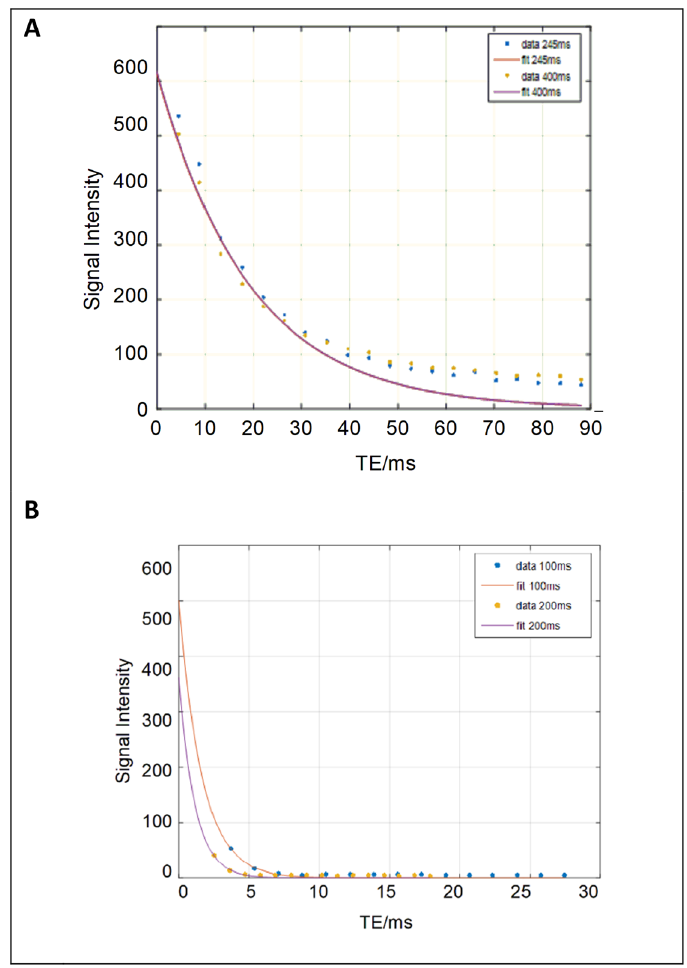
Figure 3. Decay curve of a sickle cell patient: ( A ) using auto shim, 2 × 2 mm pixel size, 10 mm slice thickness, and TR = 245 ms for T2 sequence ; ( B ) at default shim, 1 × 1 mm pixel size, 12 mm slice thickness, and TR = 100 ms for T2* sequence.